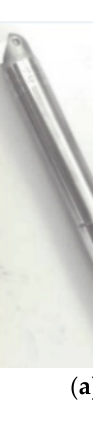
Figure 6. Tool and tool size diagram. ( a ) Tool and tool bar diagram; ( b ) Tool size diagram.